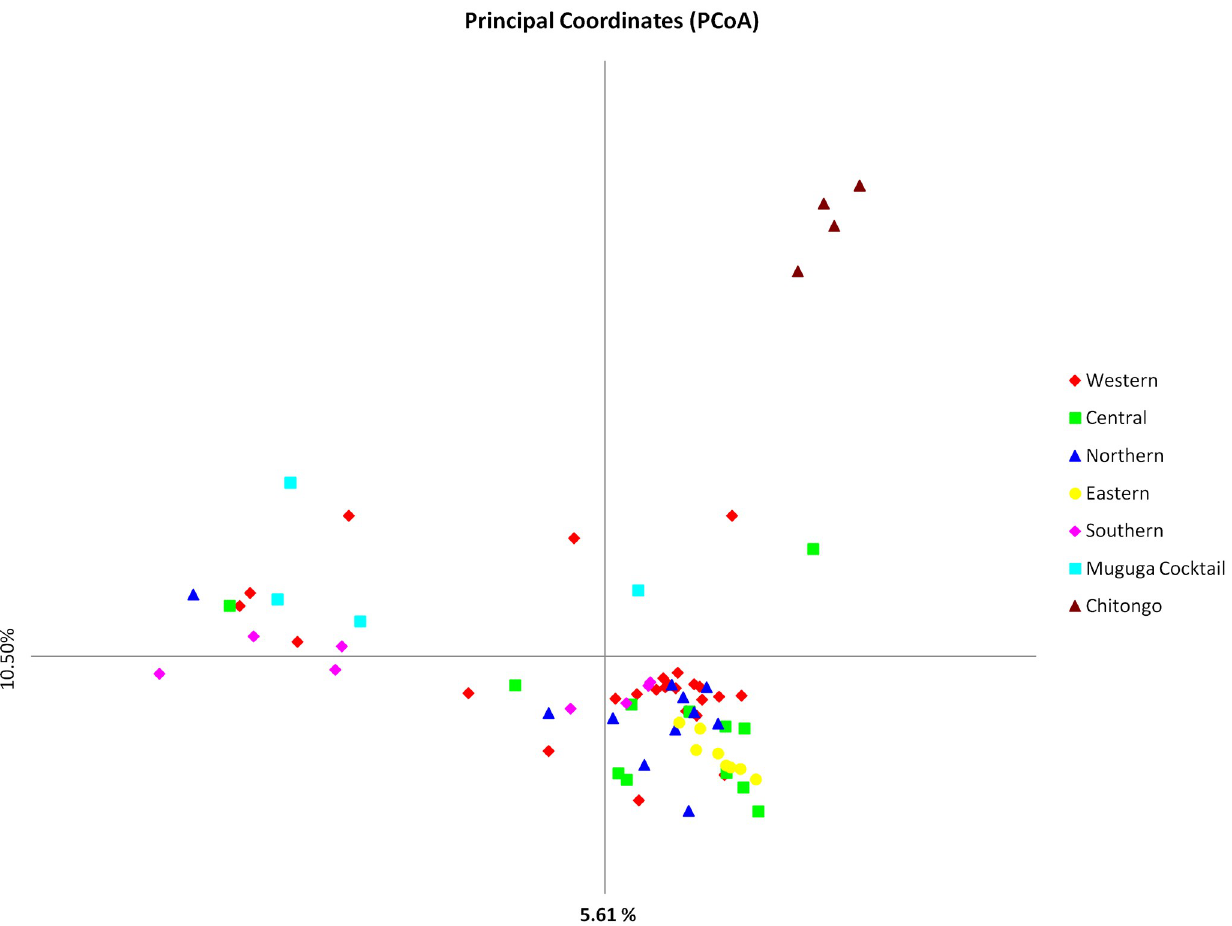
Fig 11. Principal component analysis of Burundi field samples together with the Muguga cocktail and Chitongo vaccines. The PCA plot indicates great genetic sub-structuring between the Chitongo vaccine and the Burundi field samples together with the Muguga cocktail vaccine. The variance in the data set of the population is given by the number in the parenthesis on each axis.